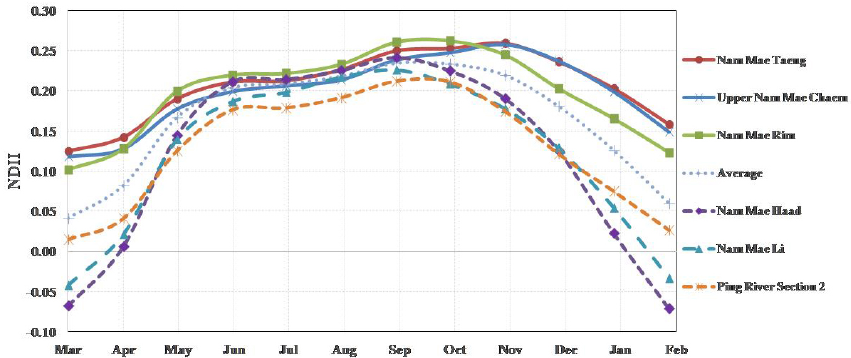
Figure 4. Monthly average NDII values for six sub-basins compared to the basin average in the UPRB. Note that three wettest and three driest basins are presented in this